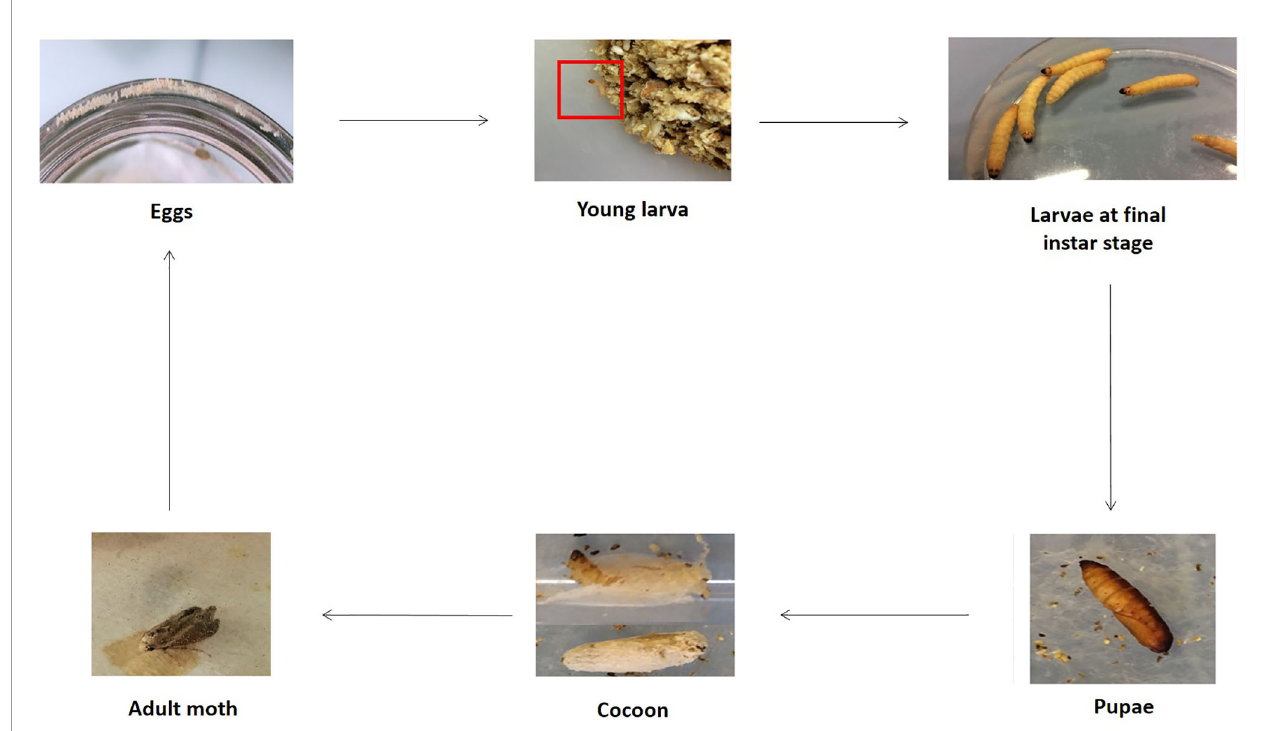
FIGURE 1 | Different stages of G. mellonella life cycle. The fourth stages are represented e.g. eggs, larvae, pupae and adult. Larvae are visible at fi rst molting stage and fi nal instar stage. Cocoons are also indicated. The entire life cycle was obtained using our rearing intern protocol. (Copyright ® : Marie